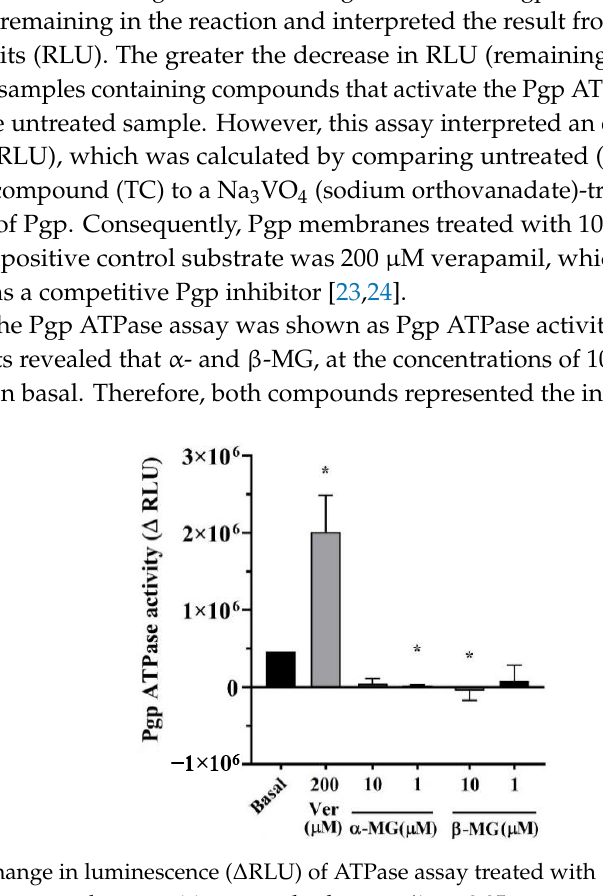
Figure 2. The change in luminescence (ΔRLU) of ATPase assay treated with α-MG and β-MG ( n = 5) Verapamil (Ver) was used as a positive control substrate. (* p < 0.05, compare to